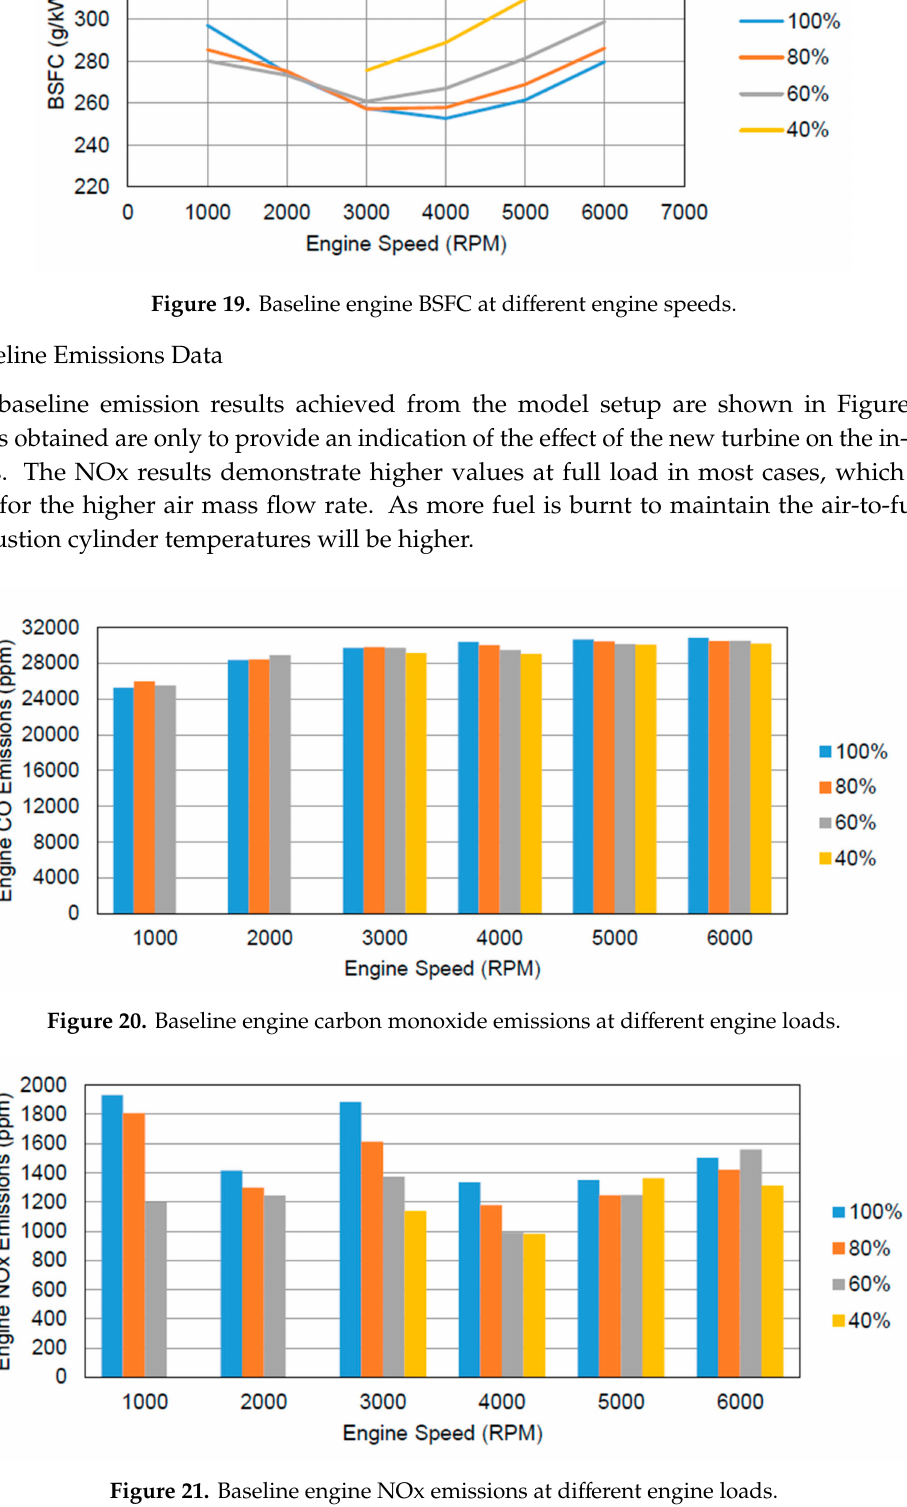
Figure 21. Baseline engine NOx emissions at di ff erent engine